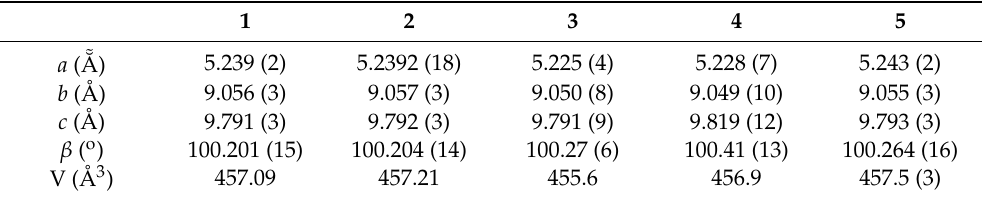
Table 2. Unit cell parameters of preiswerkite.